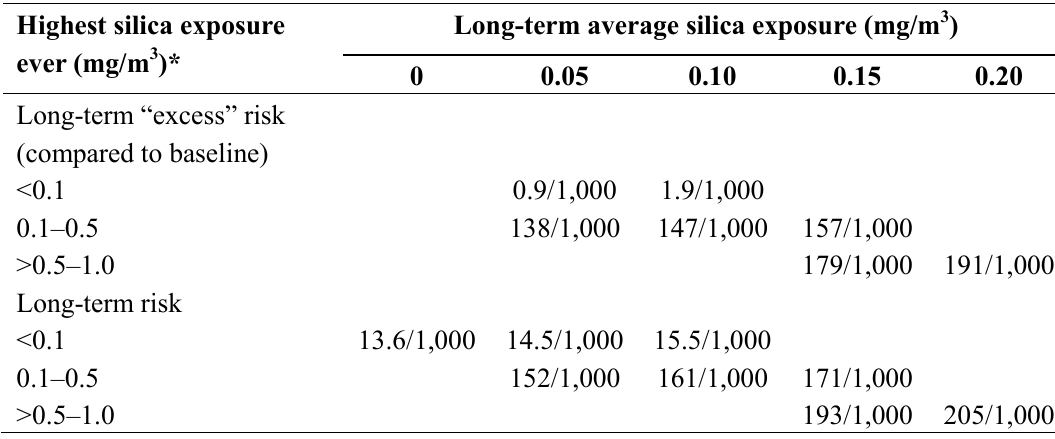
Table 5. Estimated long-term risk of silicosis by respirable crystalline silica exposure patterns in the low exposure